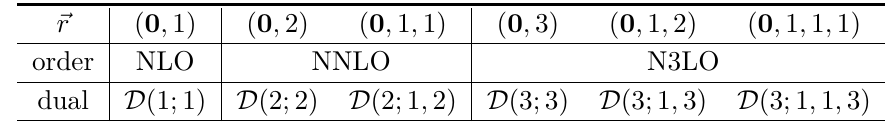
Table 8. Multivariate dual structures D for the variables ( . . . , p 0 Cutkosky cut s ( ~r ) of the LU representation up to N3LO, with a specific configuration ~r of the raised propagators crossed by the cut and its first order of appearance. We refer to the text for details.